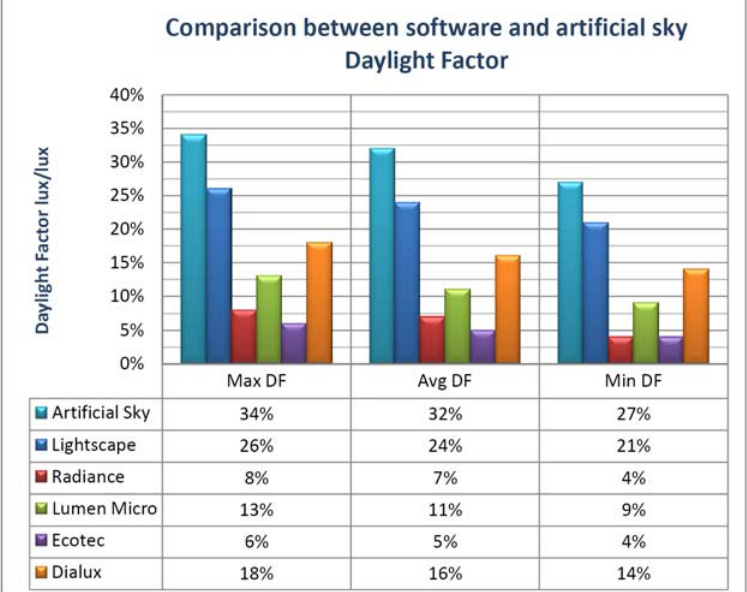
Figure 11. Comparison of Daylight Factor between software and artificial